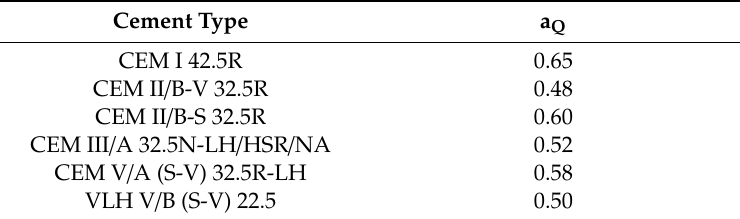
Table 3. Reduction coe ffi cient a Q .